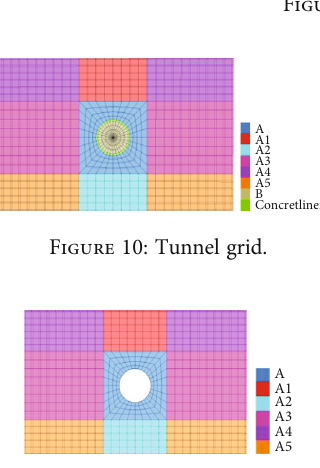
Figure 9: Vertical displacement cloud map.